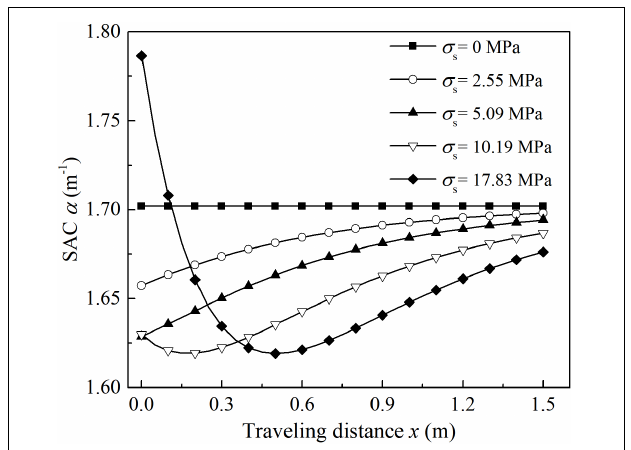
FIGURE 4 | Spatial attenuation coefficients versus traveling